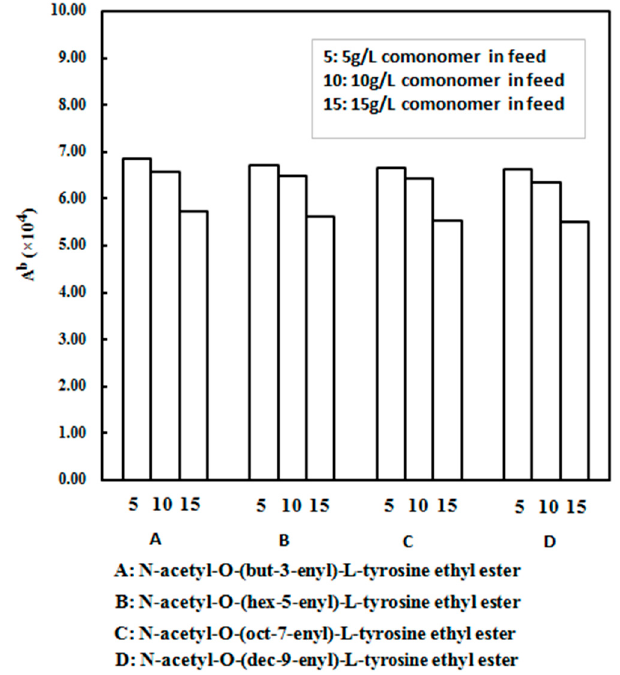
Figure 2. Activity diagrams for the copolymerization of ethylene and different comonomers with titanium complex.